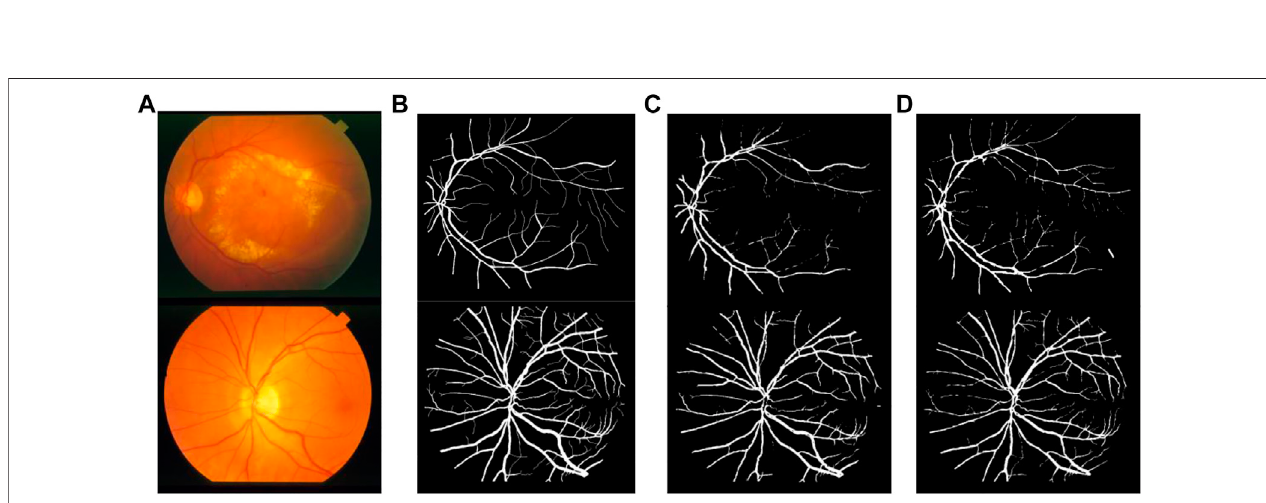
FIGURE12| ComparisonofsegmentationresultsofdifferentalgorithmsonDRIVEdatasets: (A) Originalfundusimage, (B) Referencestandard, (C) ResultsinRef. (Fan et al., 2019), and (D) Results by proposed method.